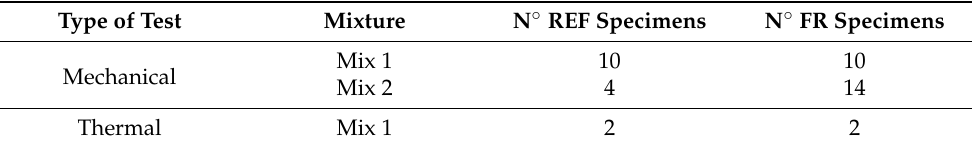
Table 1. The number of specimens tested according to the mixture